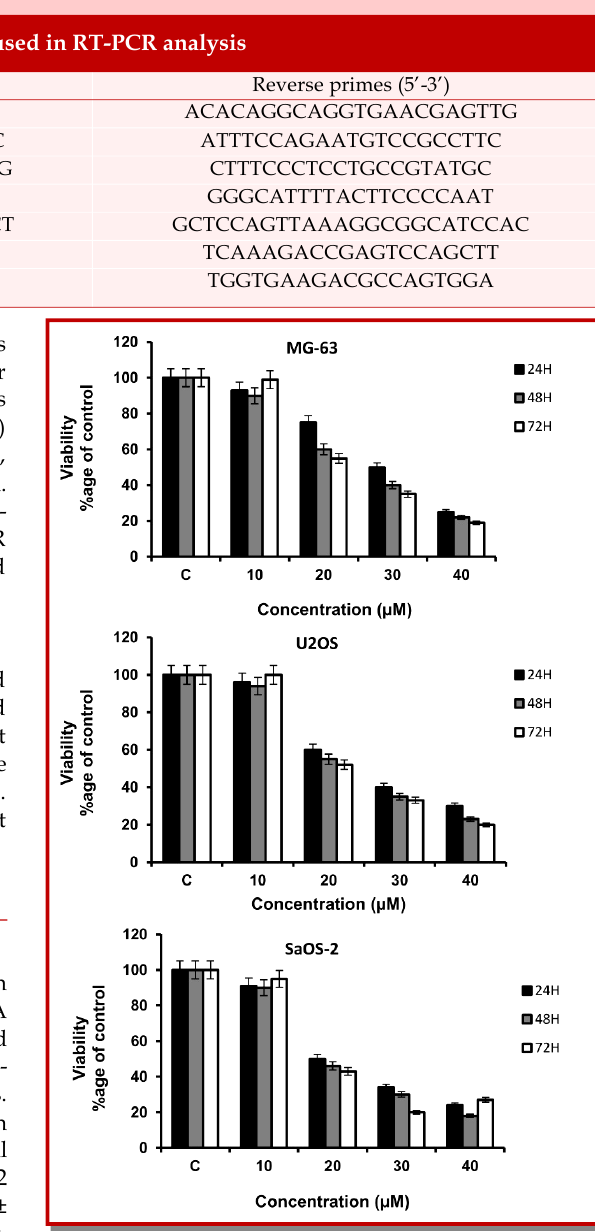
Figure 1: Effect of withaferin A on osteosarcoma cell viability was tested by MTT